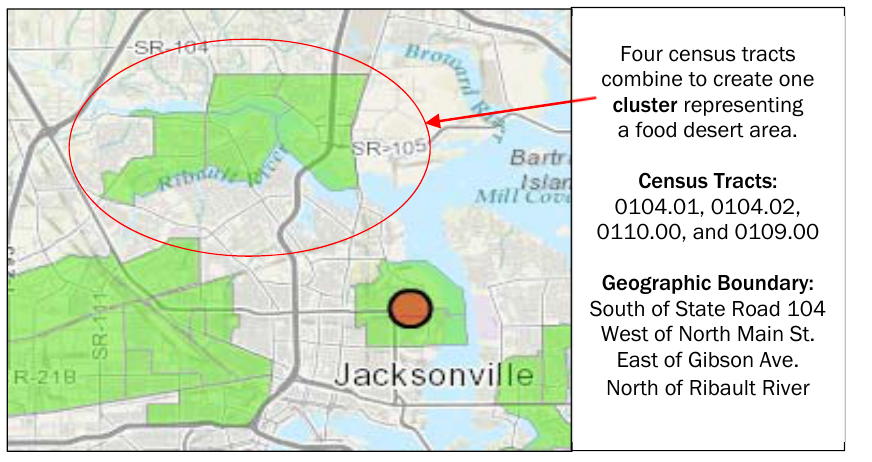
Figure 2. Cluster of Four Census Tracts Identified as Food Deserts in the North End of Jacksonville,